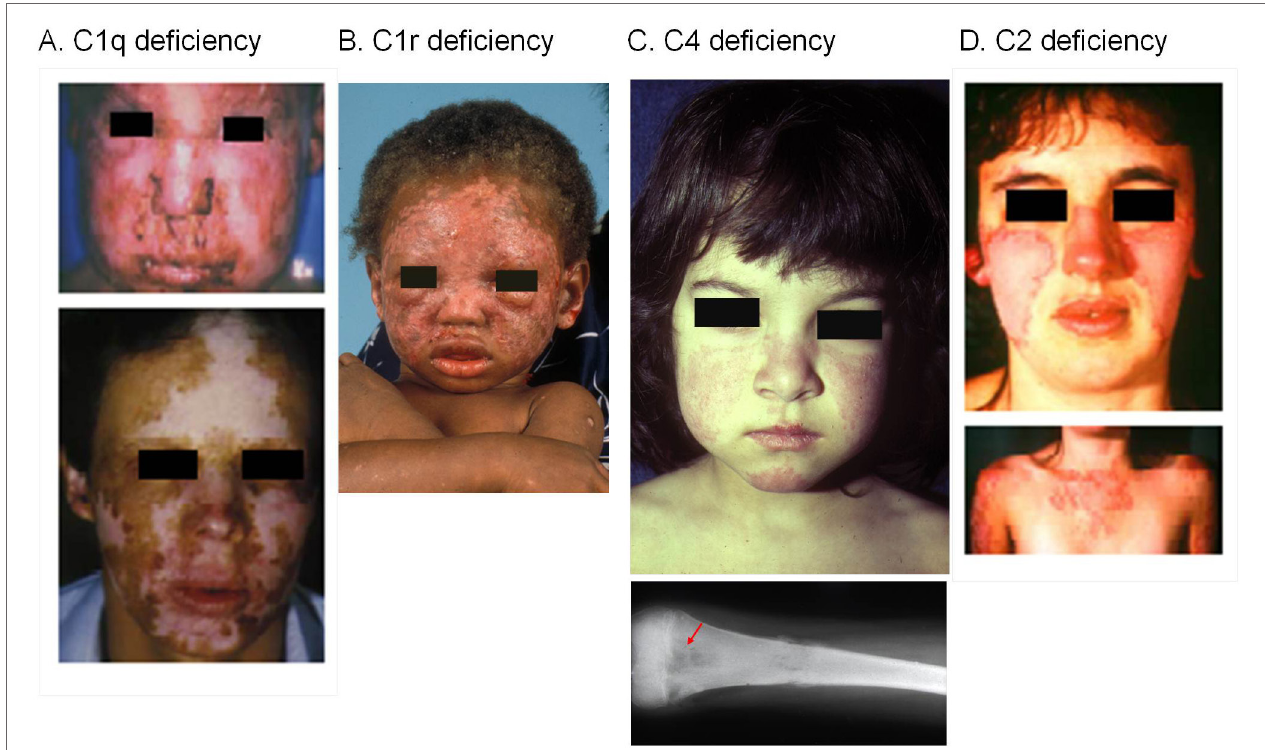
FiGURe 3 | SLe patients with a homozygous deficiency of early components for the classical pathway of complement activation . Severe cutaneous lesions are common clinical presentations in SLE patients with a complete complement deficiency. (A) A homozygous C1q-deficient male child with cutaneous infection (upper panel) and with discoid lupus erythematosus and scarring lesions on face when he was 22 years old (lower panel). (B) A male child with discoid lupus at 16-month old with homozygous C1r-deficiency. This patient experienced generalized seizures, developed a scissoring gait with toe walking, spasticity and weakness of the legs. At 18 years old, he was diagnosed with class IV lupus nephritis and progressed to end-stage renal disease. (C) A complete C4-deficient girl at 3 years old with butterfly rash and cheilitis (upper panel), and osteomyelitis of the femur at 10 years old (lower panel). This patient died at age 12 because of pulmonary infection and cardiovascular failure. (D) A homozygous C2-deficient young woman with acute cutaneous lupus erythematosus. The upper panel shows the butterfly rash, and the lower panel shows photosensitive lesions on sun-exposed areas [adopted from Ref.